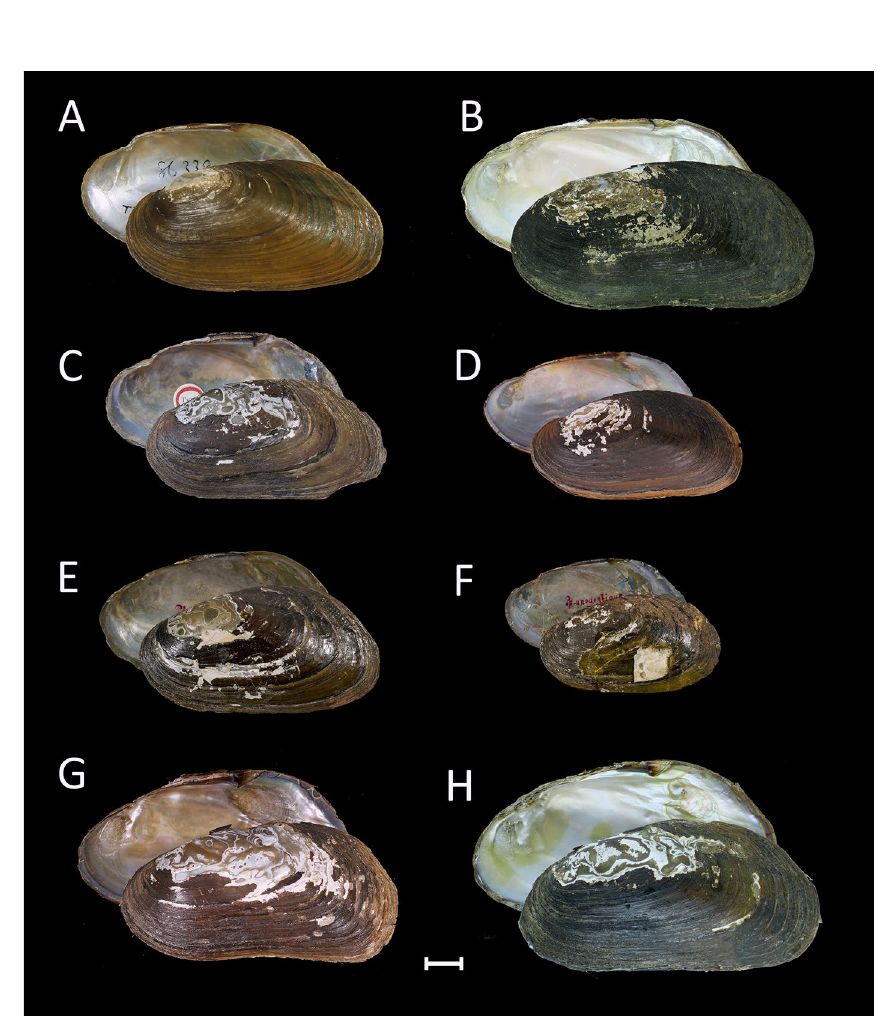
Figure 2. Shells of Bineurus species from the Mekong basin. ( A ) B. mouhotii (Lea, 1863) [holotype USNM 86339]; ( B ) B. mouhotii [RMBH biv182_19, Nam Long River, Nam Ou basin, Mekong, Laos]; ( C ) B. exilis (Morelet, 1866) stat. rev. [lectotype NHMUK 1893.2.4.1981]; ( D ) B. exilis stat. rev. [topotype UF 507440 (ICH- 00610), tributary of Tonle Sap River, Mekong River basin, Cambodia]; ( E ) Pseudodon pierrei Rochebrune, 1882 syn. nov. [syntype MNHN-IM-2000-1760] (= B. exilis ); ( F ) B. anodontinum (Rochebrune, 1882) stat. rev. [syntype MNHN-IM-2000-1638]; ( G ) B. anodontinum stat. rev. [topotype UF 507419 (ICH-00553), Mekong River basin, Sambour, Cambodia]; ( H ) B. loeiensis sp. nov. [holotype RMBH biv119_1, Loei River, Thailand]. Scale bar = 1 cm. Photos: Ilya V. Vikhrev [A]; Ekaterina S. Konopleva [B, H]; Kevin Webb (NHMUK Photographic Unit) [C]; Manuel Caballer (ANR-11-INBS-0004; 2018 MNHN Project “RECOLNAT”) [E, F]; and John M. Pfeiffer [D,